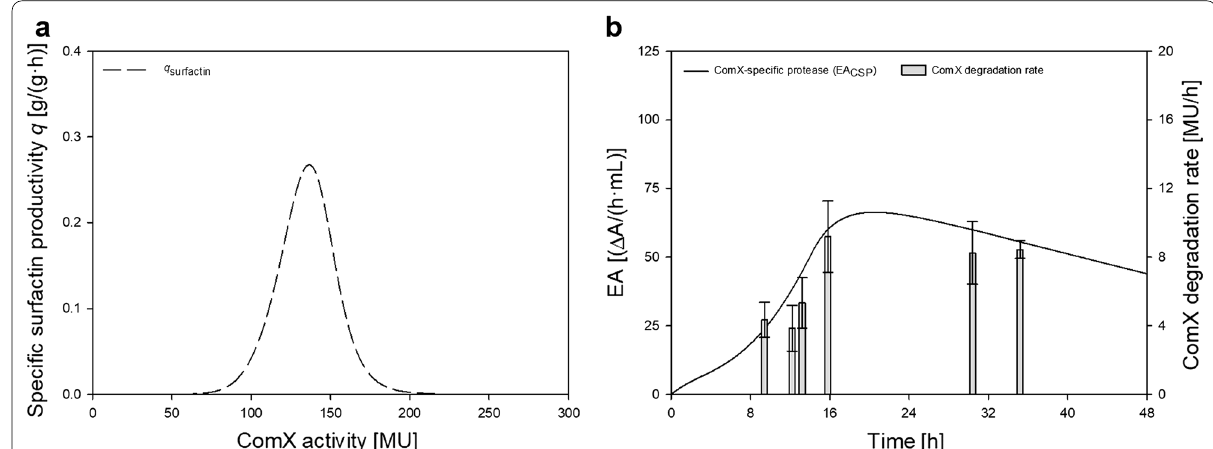
Fig. 3 a Specific surfactin productivity q Surfactin (dashed line) in relation to ComX activity; b Time course of modeled peptidase activity of putative ComX-specific protease EA